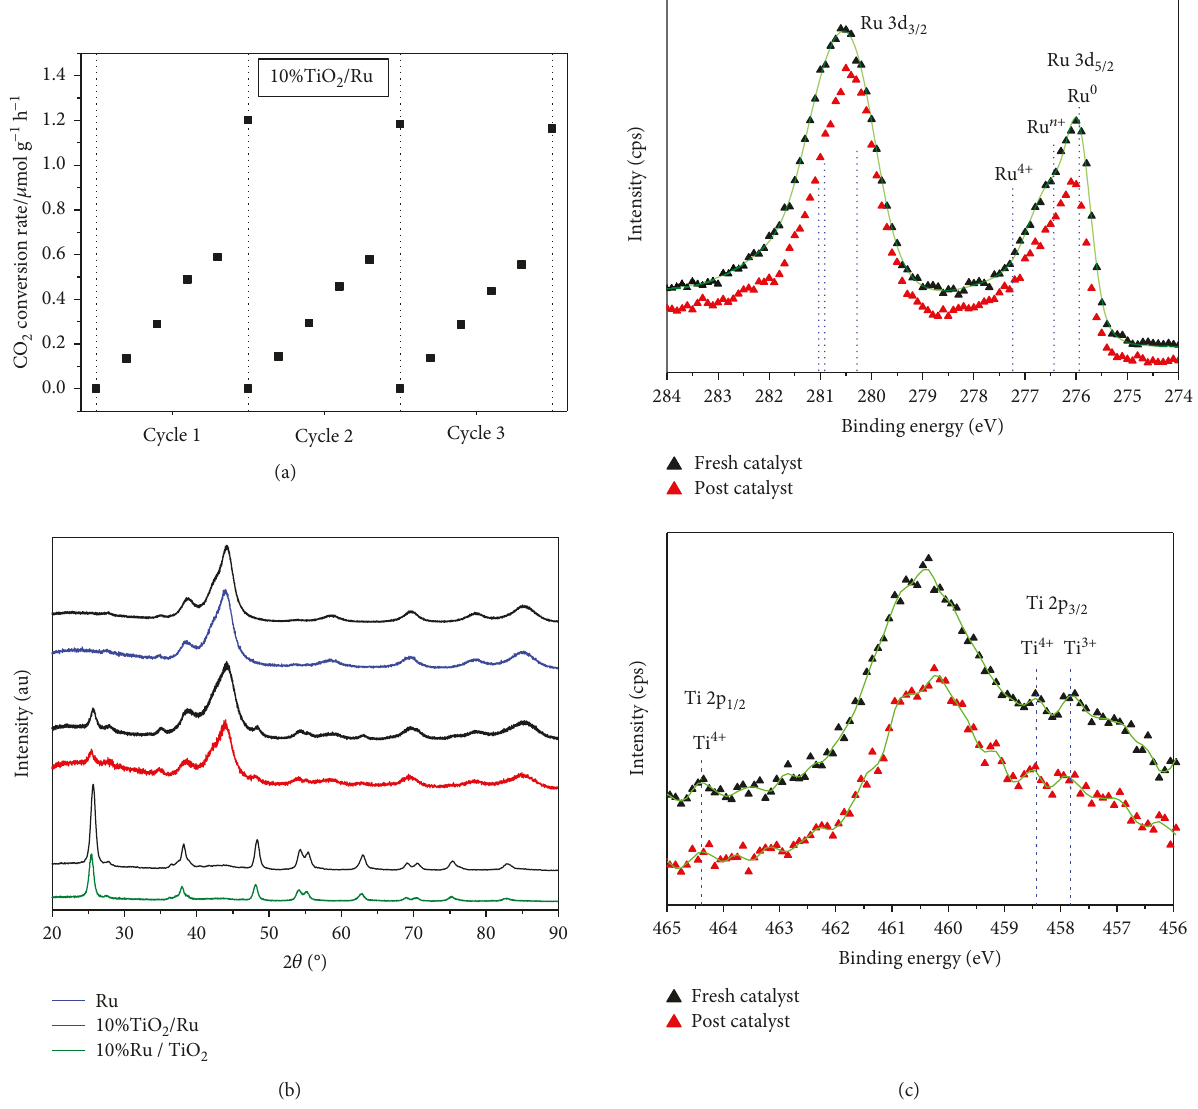
Figure 8: (a) Reactivity of the 10%TiO /Ru catalyst over three reaction cycles, (b) pXRD pro fi les for the three catalysts following reaction 2 (compared to the pro fi les from the fresh catalysts), and (c) XPS pro fi les of the 10%TiO /Ru catalyst before and following reaction showing 2 that no surface chemical changes had taken